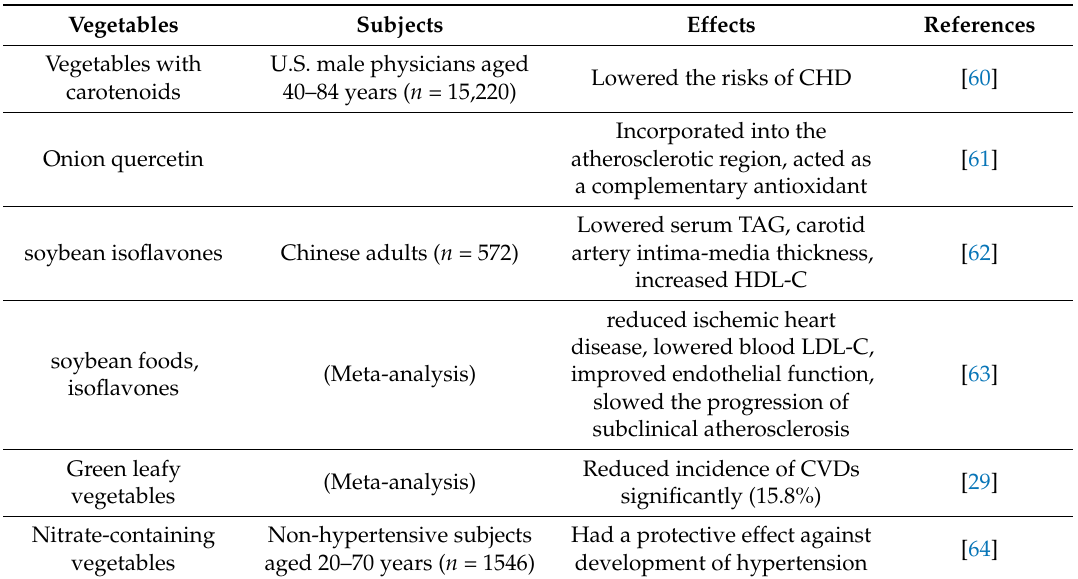
Table 1. Other vegetables associated with